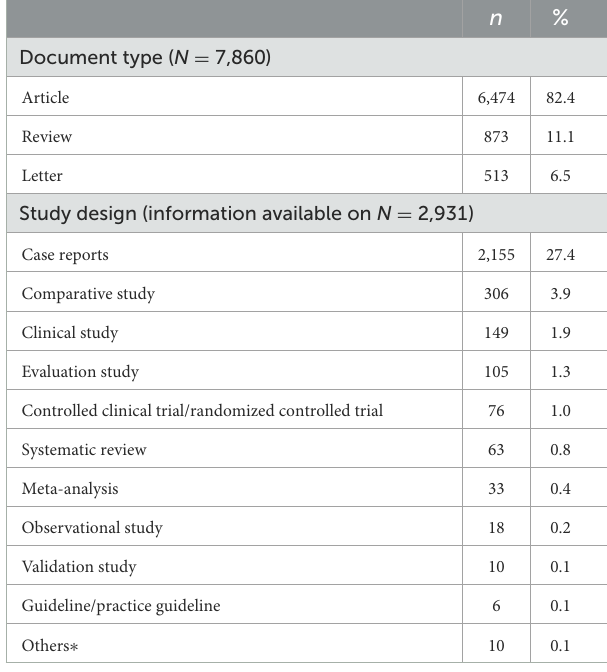
TABLE 1 Publications on cysticercosis and neurocysticercosis indexed in the MEDLINE database, according to document type and study